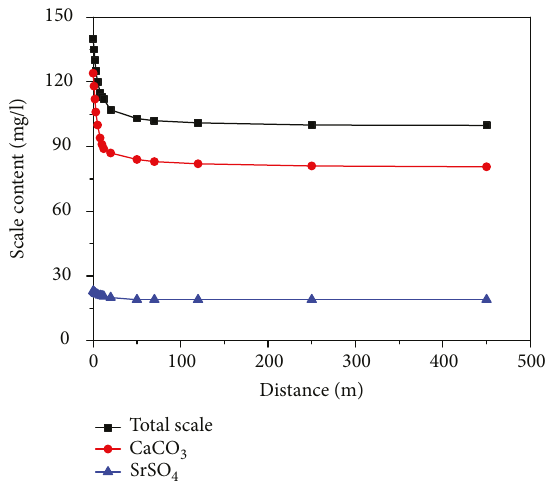
Figure 8: Balanced scaling amount in BS8 formation